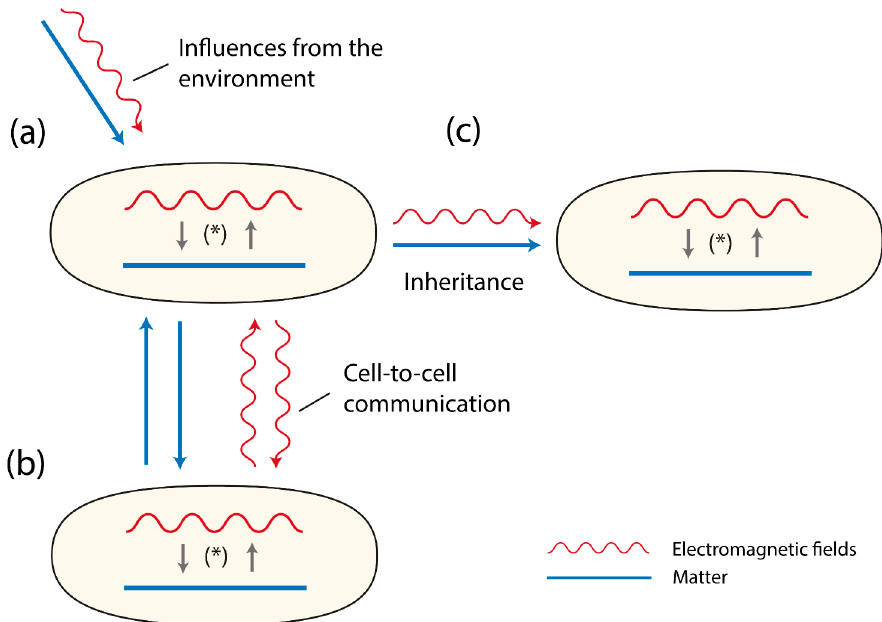
Figure 1. Three cells (organisms) are shown. They contain matter (depicted as a line) and EMFs (depicted as a wave-line). Both matter and EMFs interact with each other as a system of reciprocal causality, together building the evolving double-aspect of life (*). In ( a ) the sensitivity to environmental influences are presented depicting two types of influences, material ones (e.g., food, ions, parasites) and EMFs (e.g., cosmic rays, photons, IR-waves). In ( b ) the figures refer to the signaling between cells or organisms either via material components (e.g., pheromones, neurotransmitters, hormones)